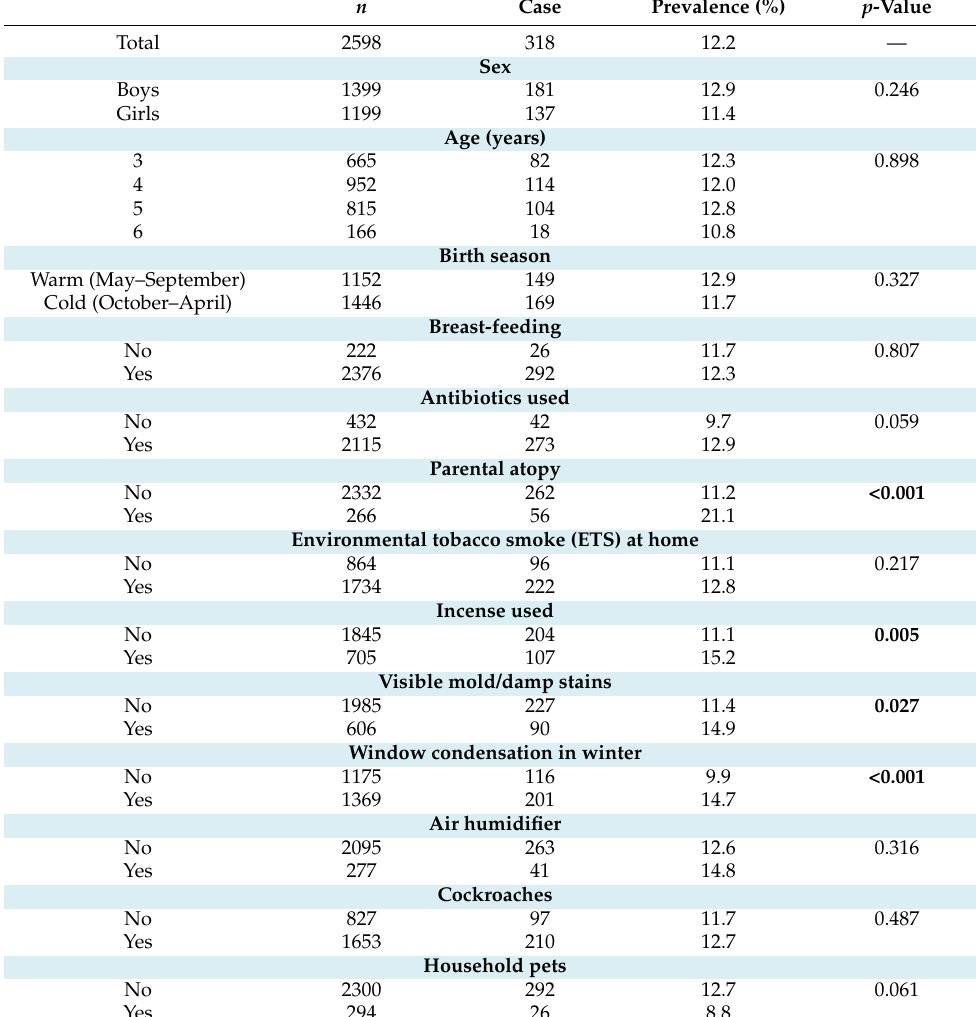
Table 1. Demographic information and prevalence of SAR to pollen among children ( n = 2598). n Case Prevalence